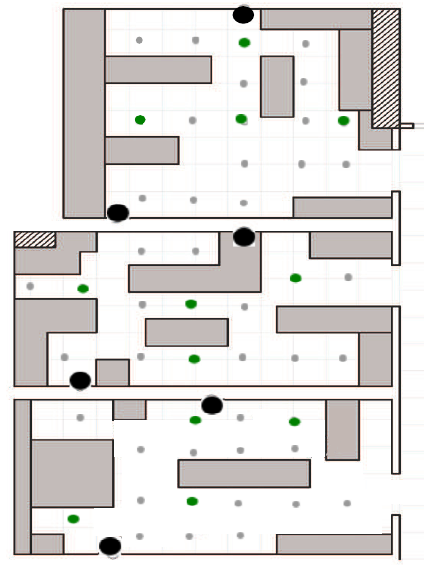
Figure 9. Test-bed environment: the positions of the anchors (black circle), the twelve mobile positions (green circle) and the grid with side 1 m (grey circle) used by the LMS algorithm are